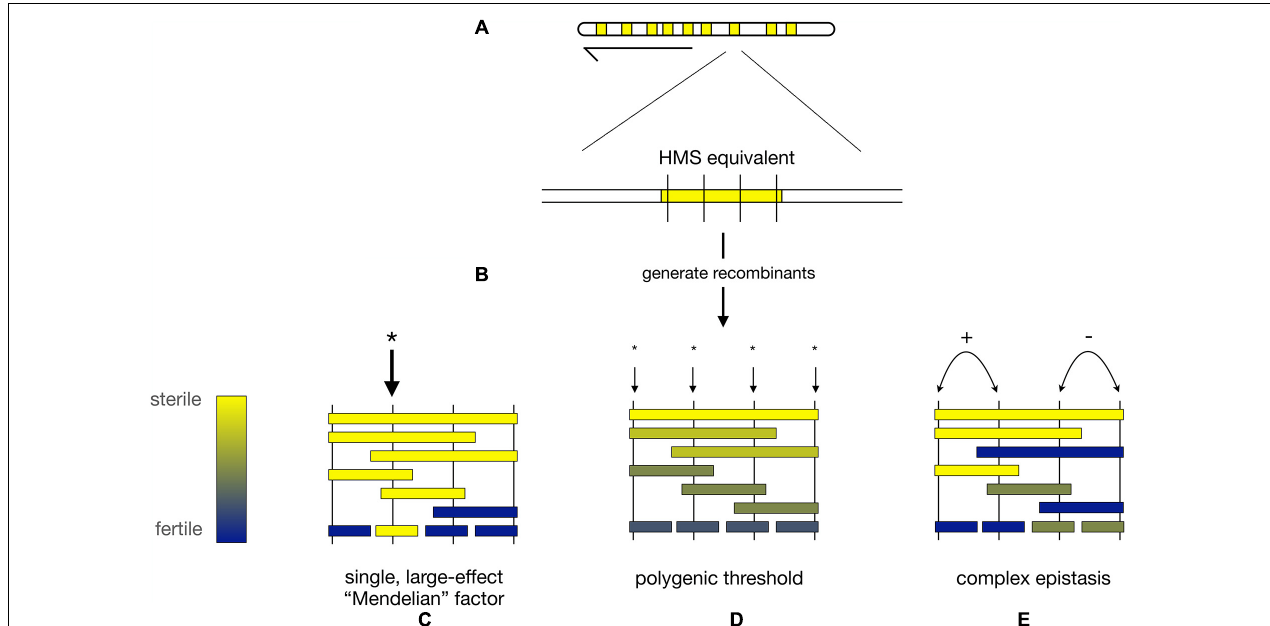
FIGURE 3 | Alternative models for the genetic architecture of HMS. (A) Hypothetical map of nine X-linked regions from D. mauritiana ( mau ) that each cause strong HMS when introgressed into a D. simulans ( sim ) genetic background (“HMS equivalents,” yellow). (B) Fine-scale recombination mapping is used to dissect the genetic basis of each HMS equivalent region. (C) HMS regions may contain a single mau factor of large phenotypic effect (* = location of HMS factor). (D) Under the polygenic threshold model, multiple, interchangeable mau factors individually contribute to HMS; complete HMS occurs when a sufficient, threshold number of polygenic HMS factors is present simultaneously. (E ) Under the complex epistasis model, two (or more) loci interact to determine the HMS phenotype. In the figure, there are two pairs of adjacent, epistatically interacting loci. The left pair of loci shows synergistic epistasis ( + ) in which two mau alleles interact to produce stronger HMS than the sum of their individual effects. The right pair of loci shows antagonistic epistasis ( − ) in which two mau alleles interact to produce weaker HMS than the sum of their individual effects.